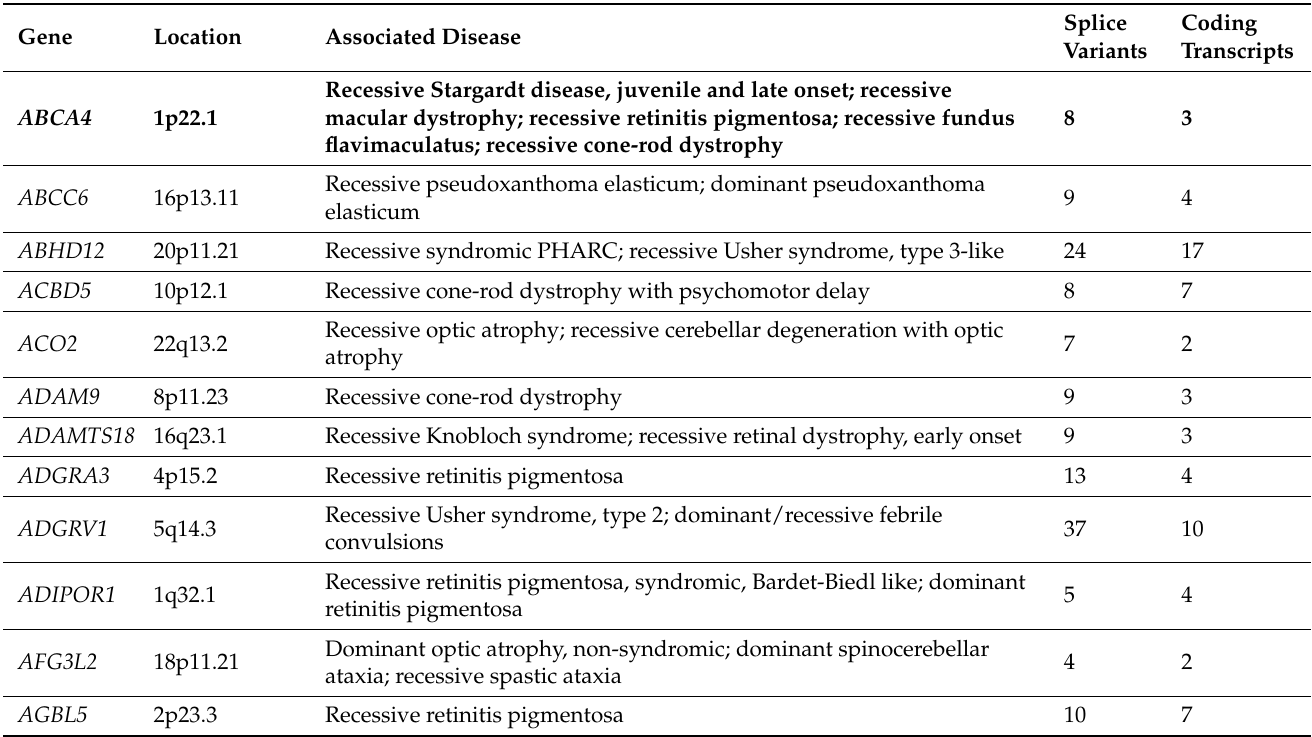
Splice Coding Variants